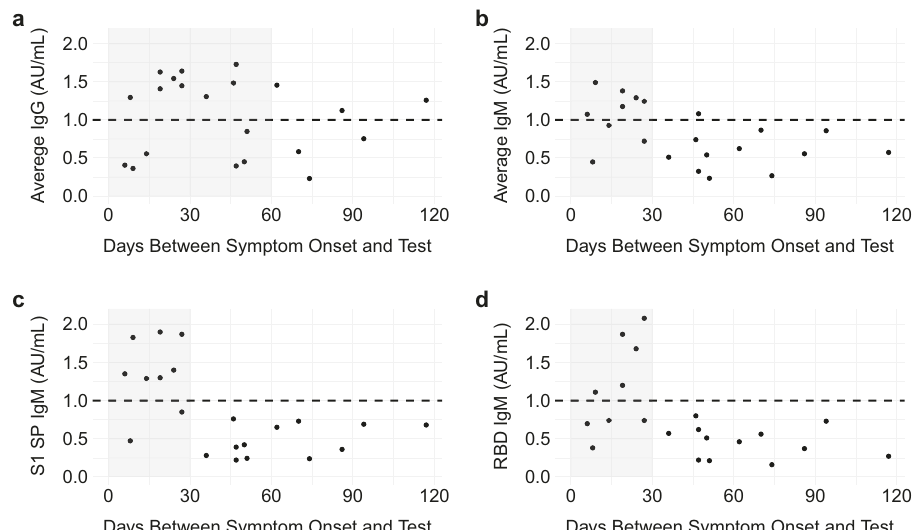
Fig. 2 IgG and IgM antibody titers plotted against days between symptom onset and serological test for COVID-19-positive participants. Black dots represent a average IgG antibody titers, b average IgM antibody titers, c average IgM antibody titers against the spike 1 glycoprotein (S1 SP), and d average IgM antibody titers against the receptor-binding domain (RBD) in symptomatic COVID-19-positive ( n = 21) participants plotted against days between symptom onset and serological test. The cut-off value for the serological test ( ≥ 1) is shown as a black dashed line for reference. Shaded areas represent the time interval during which the majority of black dots are in the positive range (> = 1). All data were analyzed using one-way ANOVA. Tukey post hoc tests were used for multiple comparisons. Table 3 Comparison of IgM, IgA, and IgG titers against SARS-CoV-2 spike 1 glycoprotein (S1 SP), spike 2 glycoprotein (S2 SP), receptor-binding domain (RBD), and nucleoprotein (NP) in symptomatic and asymptomatic COVID-19-positive participants.